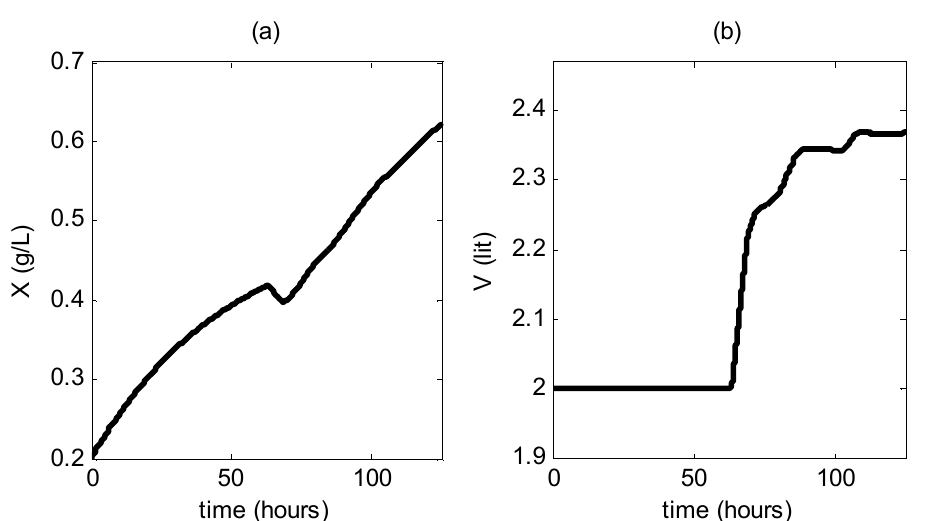
Figure 3. Simulation results for second case of reference model and controller parameter values. ( a ) Time course of the biomass concentration X. ( b ) Time course of the culture volume V.